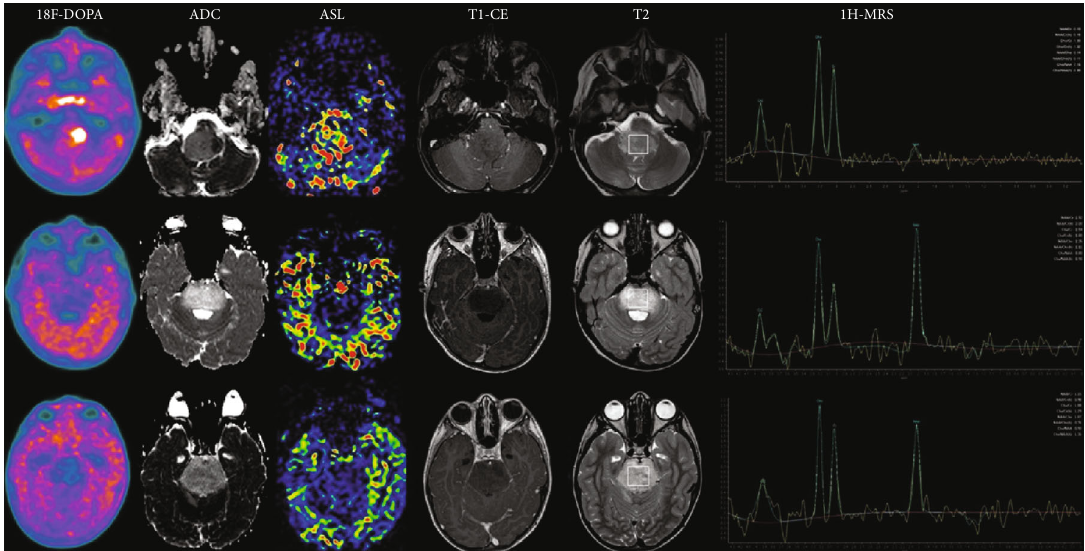
Figure 8: FDOPA PET combined with MRS in di ff use midline glioma (DMG). 18 F-DOPA PET and MR images of H3K27M-mutant and wild-type DMG. Upper row: DMG, H3K27M-mutant, and WHO grade IV; 18 F-DOPA PET shows an area of markedly increased uptake within the lesion (tumor/normal [T/N] ratio: 2.80; tumor/striatum [T/S] ratio: 1.80). ADC demonstrates a focal area with mildly reduced di ff usivity (rADC min: 0.95) on the left side of the lesion corresponding to the 18 F-DOPA PET hot spot region. ASL shows increased perfusion (rCBF max: 1.90). Contrast-enhanced (CE) T1-weighted MR image does not show contrast enhancement. 1 H-MRS demonstrates marked increase of Cho/NAA (7.15) and mild increase of Cho/Cr (1.39) ratios. Middle row: di ff use intrinsic pontine glioma, H3K27M-wild type, and WHO grade III; 18 F-DOPA PET shows absence of tracer uptake in the lesion (T/N: 1.00; T/S: 0.60). ADC